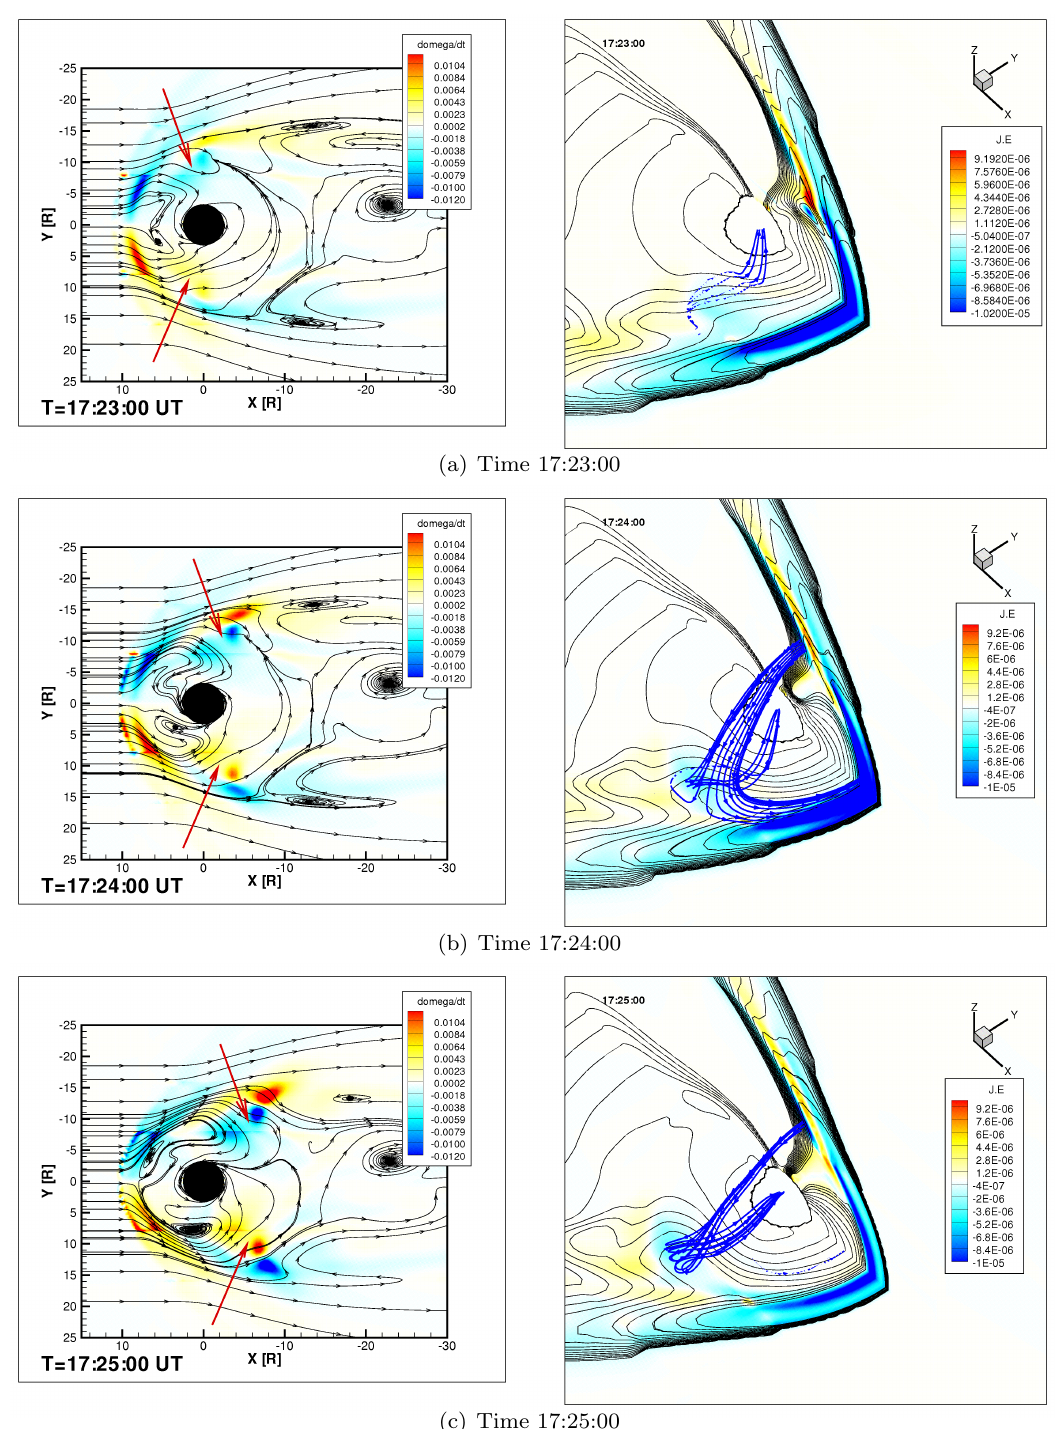
Fig. 8. Northward IMF condition: left column displays the plasma convection (shown by the black streamlines) in the equatorial plane, and d(cid:127) || the color contour is (or the l.h.s. of Eq. 1); right column shows the current flow in 3-D, and the color on Y=0 and Z=0 planes represents dt J · E , while the black contour represents the thermal pressure in the magnetosphere. The unit of